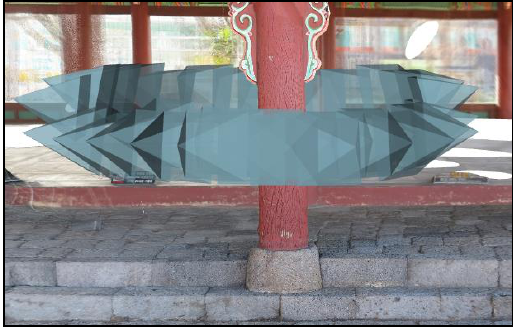
Figure 8. A photogrammetry 3-D model of column2.